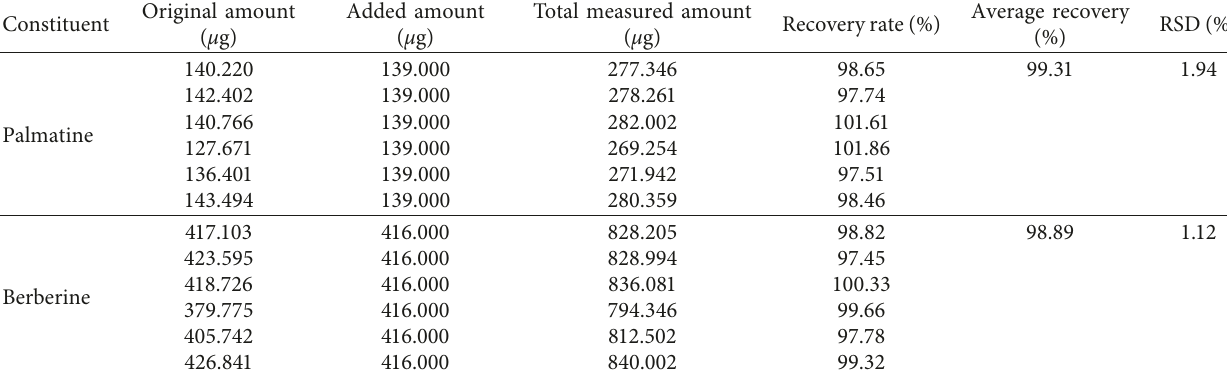
Table 2: Results of recovery test of two active